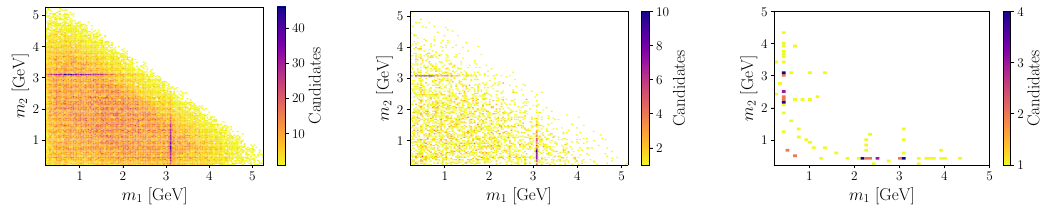
Figure 4 . Dimuon mass distributions in simulated pp → b ¯ b X events reconstructed as B 0 → a 1 a 2 → 2 µ + 2 µ − . In the left panel, only the requirements discussed in section 3 are ap- s plied. In the central panel, strong vertex requirements are applied. In the right panel, it is required instead that one of the dimuon systems has a significant flight distance. The vertexing strongly reduces the K 0 resonance at ≈ 500 MeV, while the flight distance requirement removes the J/ψ S resonance around ≈ 3